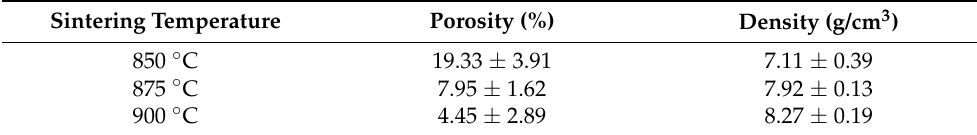
Table 2. Porosity, density values and microstructures of samples after sintering. Sintering